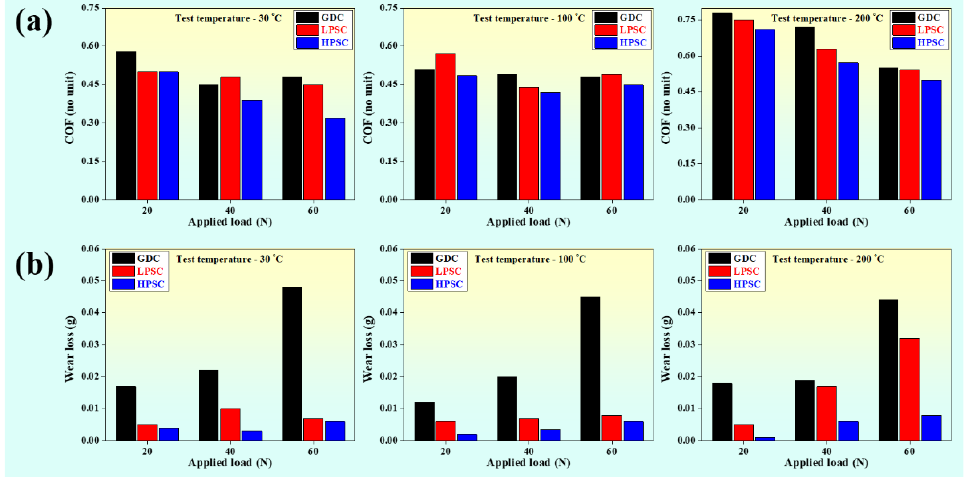
Figure 5. Tribological performance including ( a ) coefficient of friction and ( b ) wear loss comparison between GDC, LPSC, and HPSC samples as a function of load and operating temperature.